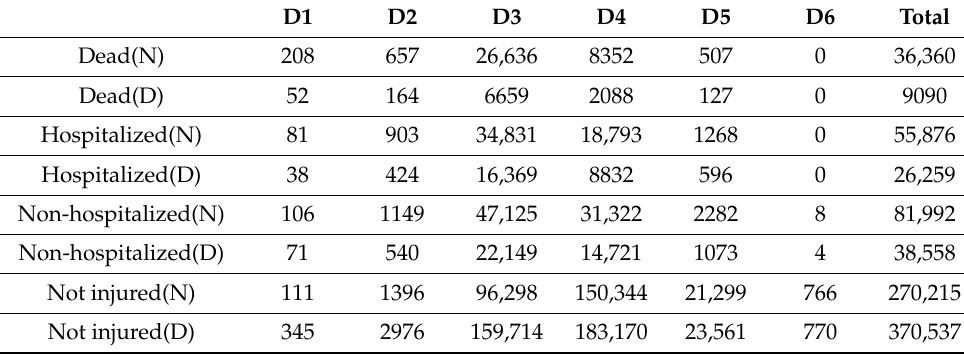
Table 23. Number of casualties in the 1780 earthquake in District 4 of